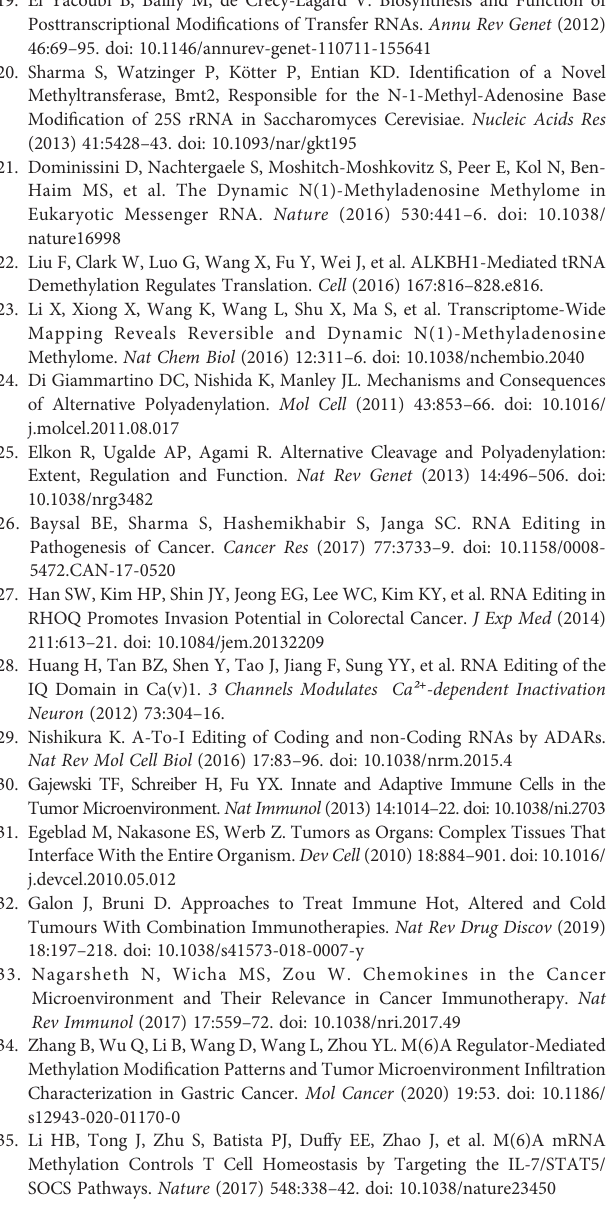
Supplementary Figure 12 | Immune in fi ltration characteristics between the two RMW score subgroups. (A) Heatmap showing the association between RMW score and immune cells. (B) The proportion of each immune cell in two RMW score subgroups. (C) Correlations between RMW score and immune cell types. (D) Heatmap shows a positive and negative correlation between drug targeted genes and RMW score in OC. Supplementary Figure 13 | The Correlation between the RMW score and genetic variations. (A) Relationships between RMW score and CSC index (RNAss). (B) RelationshipsbetweenRMWscoreandCSCindex(DNAss). (C) TMBindifferent RMWscoregroups. (D) ThewaterfallplotofsomaticmutationfeaturesinhighRMW score. E The waterfall plot of somatic mutation features in low RMW score. Supplementary Figure 14 | Scatter plots to show the association between different “ writers ” expression and drug